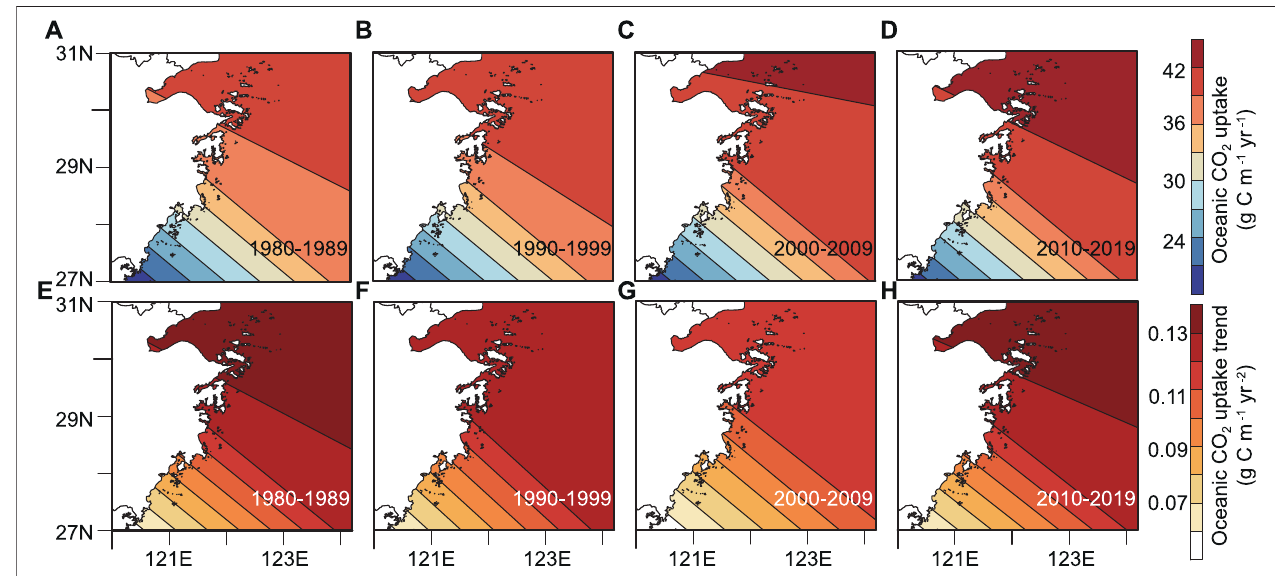
FIGURE 1 | Spatial distributions of simulated decadal mean (A – D) oceanic CO 2 uptake and (E – H) trends of oceanic CO 2 uptake in Zhejiang offshore. Results are shown for (A,E) 1980 – 1989, (B,F) 1990 – 1999, (C,G) 2000 – 2009, and (D,H) 2010 – 2019.